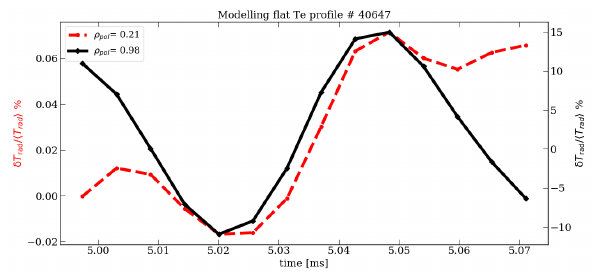
Figure 10. ECRad modeling: modelled time evolution of the radiation temperature fluctuations for the o ff -axis heating case. Black solid line shows the channel at the plasma edge while red dashed line represents the behaviour in the core.